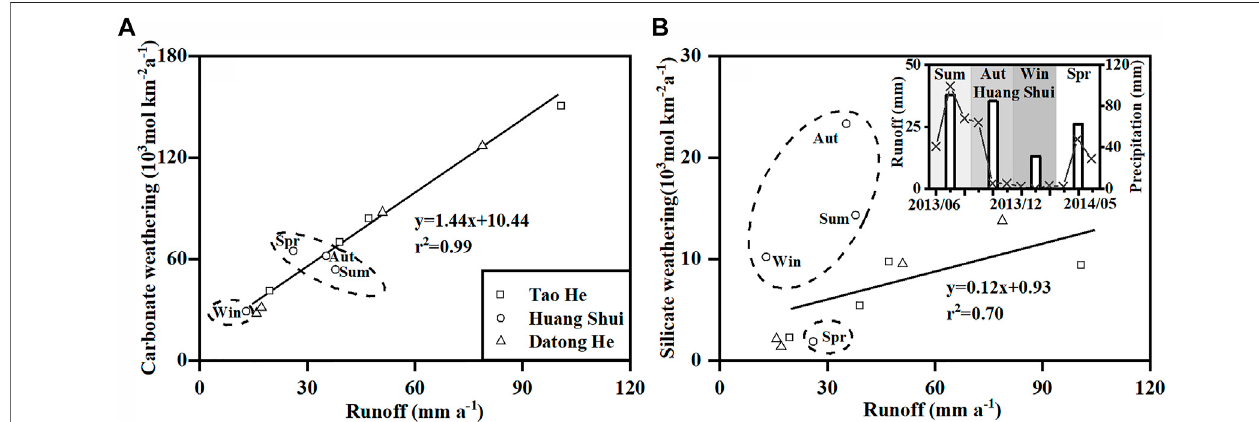
FIGURE7| RelationshipsbetweentheCO 2 consumptionratesof (A) carbonateand (B) silicateweatheringandspeci fi crunoff(waterdischarge/surfacearea)atthe outlets of the Tao He, Huang Shui, and Datong He throughout the year. Huang Shui data were excluded when calculating the correlation. The inset in panel B shows seasonal variations in runoff at the outlet and precipitation at the Xining station in the transition zone of the Huang Shui. The bars indicate runoff at the outlet. The black dotted line indicates the precipitation at the Xining station during the sampling period (Qinghai Water Resources Bulletin 3 ). Runoff data are in Supplementary Table S5